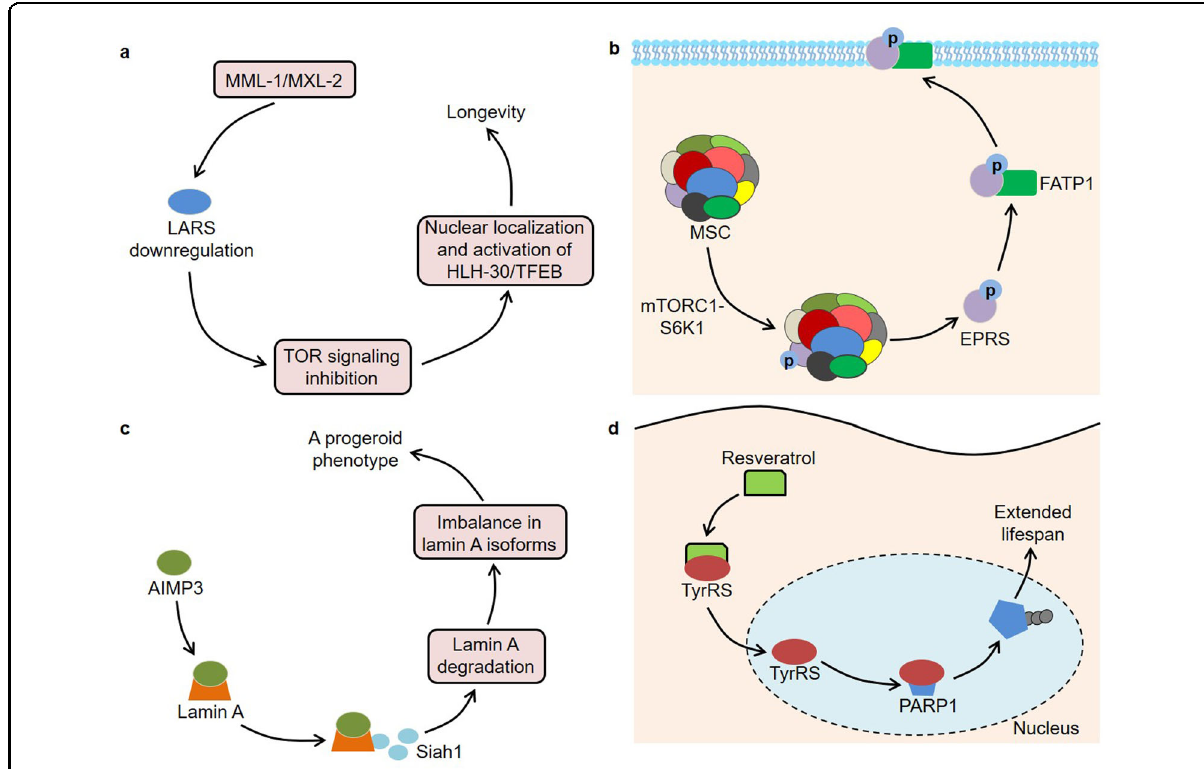
Fig. 3 The dysregulation of ARSs in aging and lifespan. a MML-1/MXL-2 inhibits TOR activity by down-regulating LARS, leading to the nuclear localization and activation of HLH-30/TFEB. b mTORC1-S6K1 phosphorylates EPRS and thus induces its release from the MSC. The phosphorylated EPRS binds to FATP1 to promote its translocation to the plasma membrane. c AIMP3 interacts with lamin A and recruits Siah1, which leads to the degradation of lamin A as well as an imbalance in its isoform levels. d Resveratrol binds to TyrRS and facilitates its nuclear translocation. Then, TyrRS interacts with PARP1 and promotes its activation by stimulating NAD + -dependent